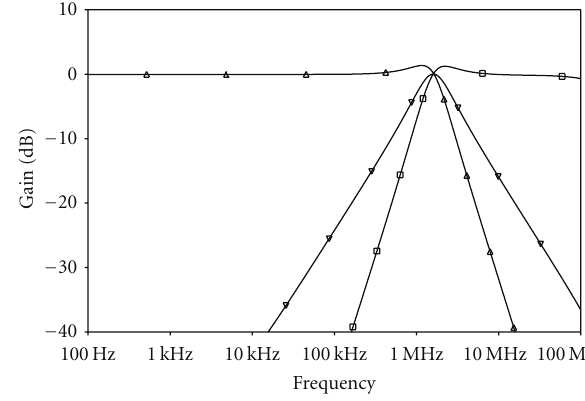
Figure 7: Simulated responses of the proposed voltage mode filter.